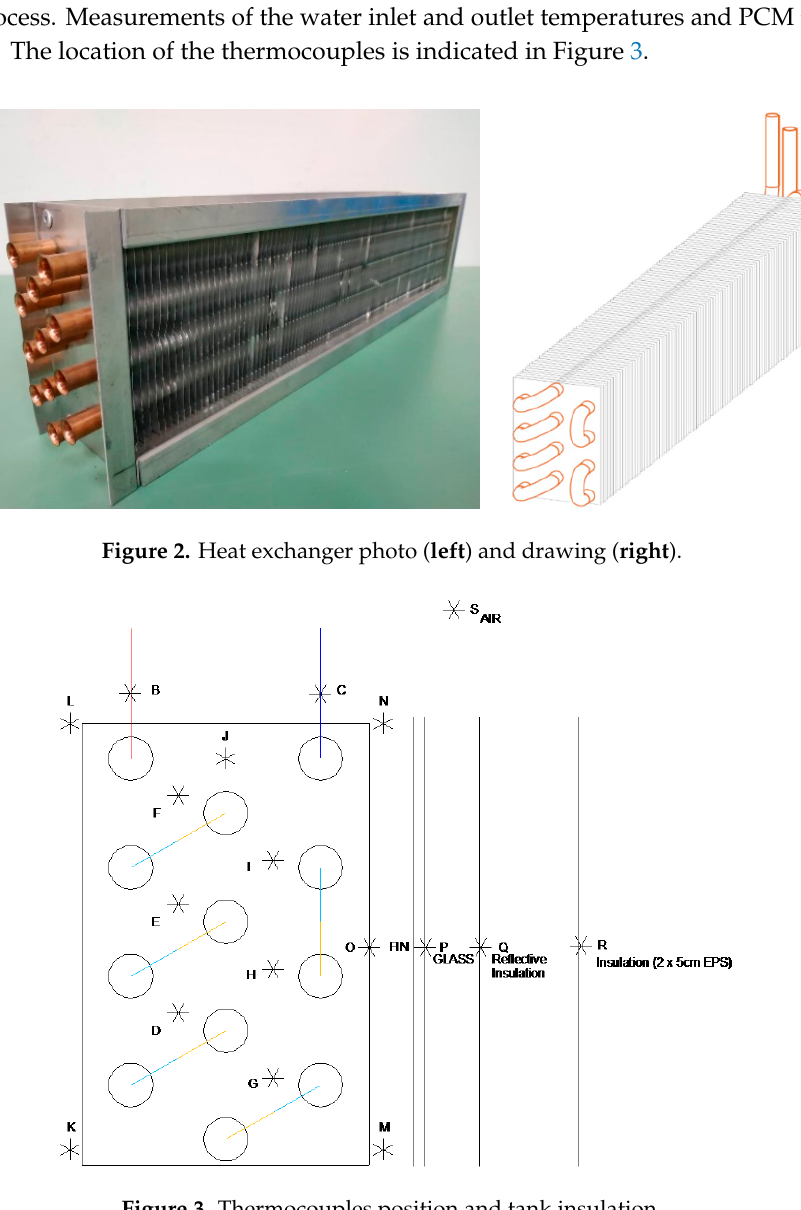
Figure 3. Thermocouples position and tank insulation.